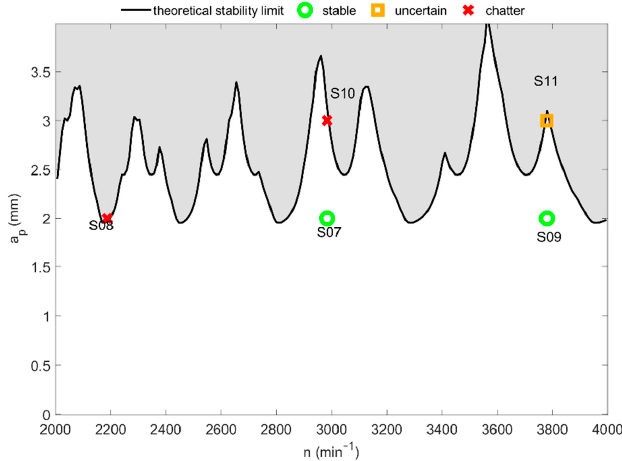
Figure 5. Stability lobe diagram for the slender end mill Iscar E90AN based on measured FRF and compared with machining stability tests: overhang L = 50 mm (Experiment 1).